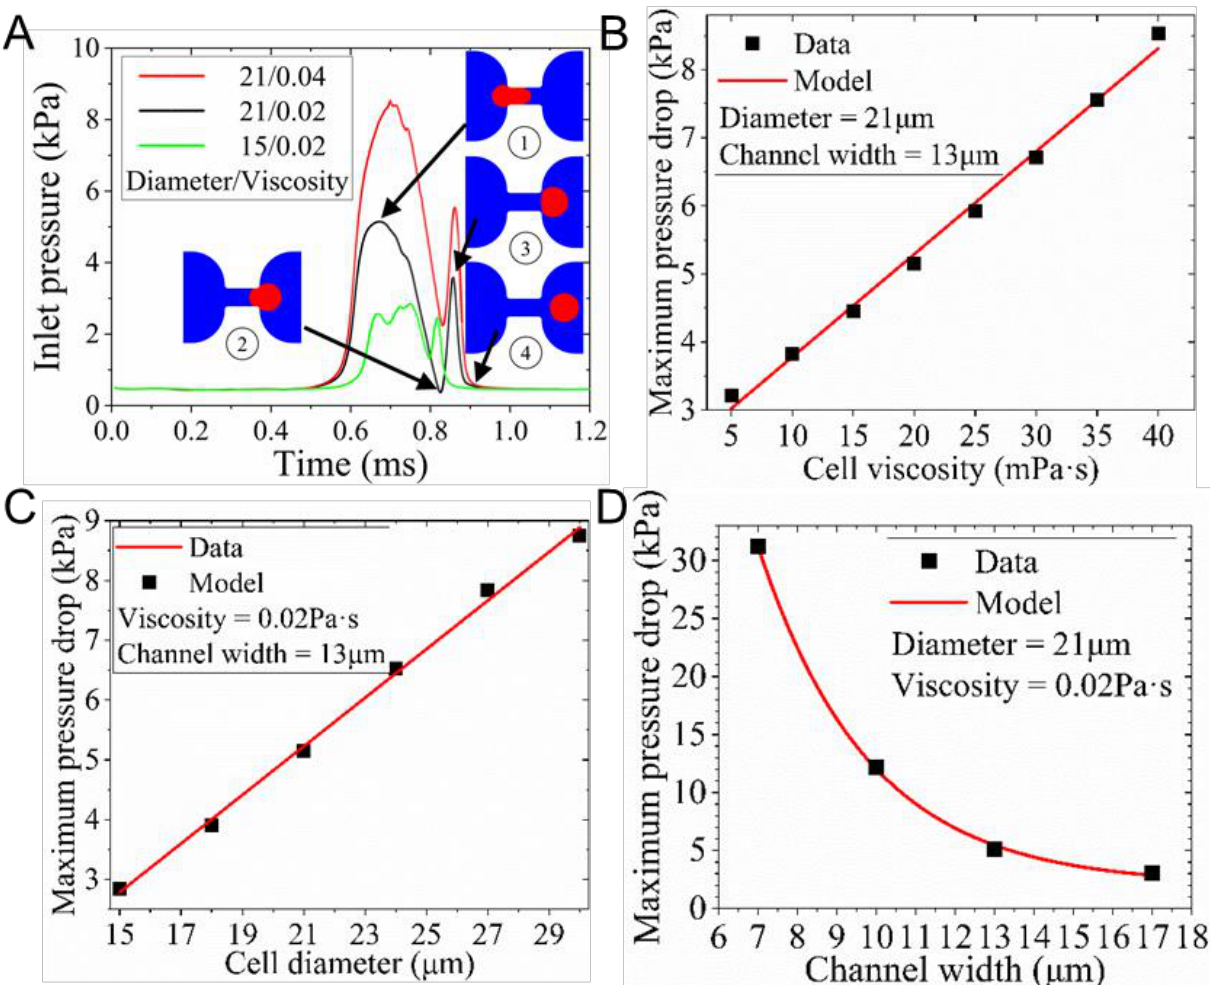
Figure 3. Studies of a cell passing a filtration channel modeled using a droplet. ( A ) The variation of the pressure drop inducing the deformation of cells with distinct sizes and viscosities at the inlet velocity of 0.04 m/s. The relationship between the maximal pressure drop and ( B ) the viscosity, ( C ) cell diameters, or ( D ) channel width.